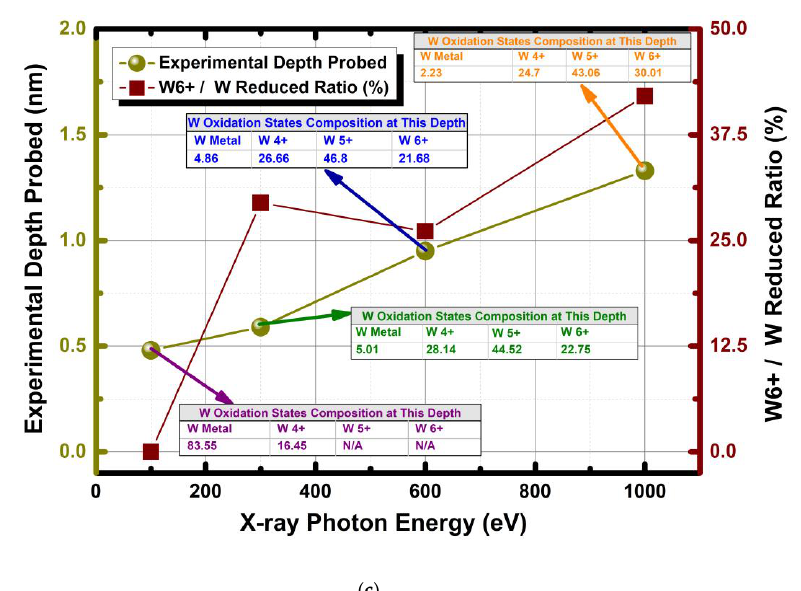
Figure 3. Non-destructive depth profiling of 600 ◦ C substrate temperature deposited WO 3 thin film with varying X-ray photon energy excitements. ( a ) The probed depth as a function of X-ray photon energy, ( b ) The deconvoluted W 4f photoelectron lines measured by 100, 300, 600 and 1000 eV X-ray photons. ( c ) Quantification of oxidation states as a function of probed depth with di ff erent X-ray excitations energies and change of the relative percentages of the fully oxidized state of tungsten (W 6 + ) vs. the reduced states (W 5 + , W 4 + and W Metal